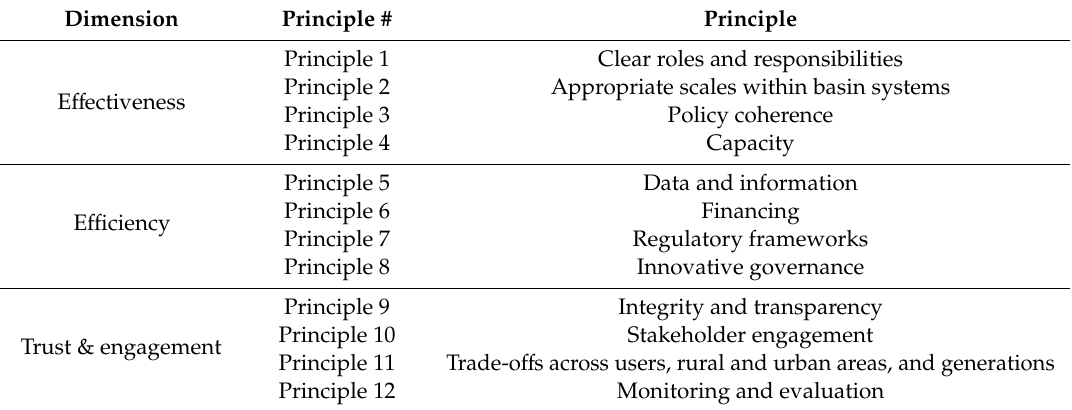
Trade-o ff s across users, rural and urban areas, and generations Principle 12 Monitoring and evaluation Source: OECD